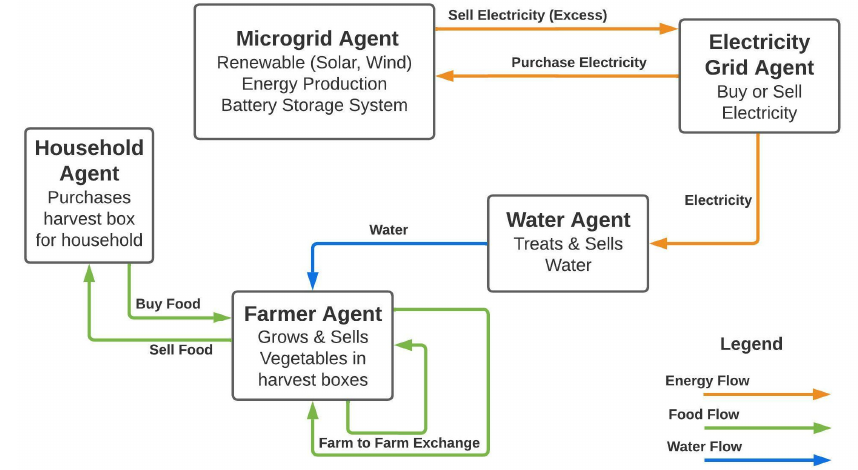
Figure 1. Interactions of the agents in the ABM simulation and corresponding flows.